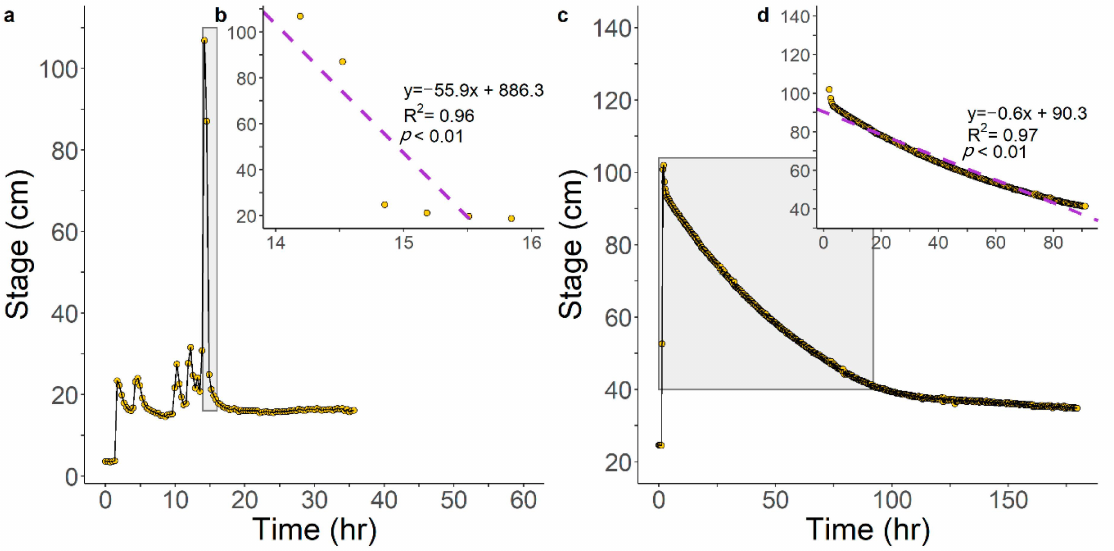
Figure 9. Outlet stage response to a 1.1 cm rain event in November of 2018 for the dry detention basin ( a , b ). Outlet stage response to a 1.1 cm rain event for the wetland in November of 2019 ( c , d ). The slope of the stage decline for the basin ( b ) was almost 2 orders of magnitude steeper than the wetland ( d ). Grey-shaded boxes denote range of inset graphs ( b , d